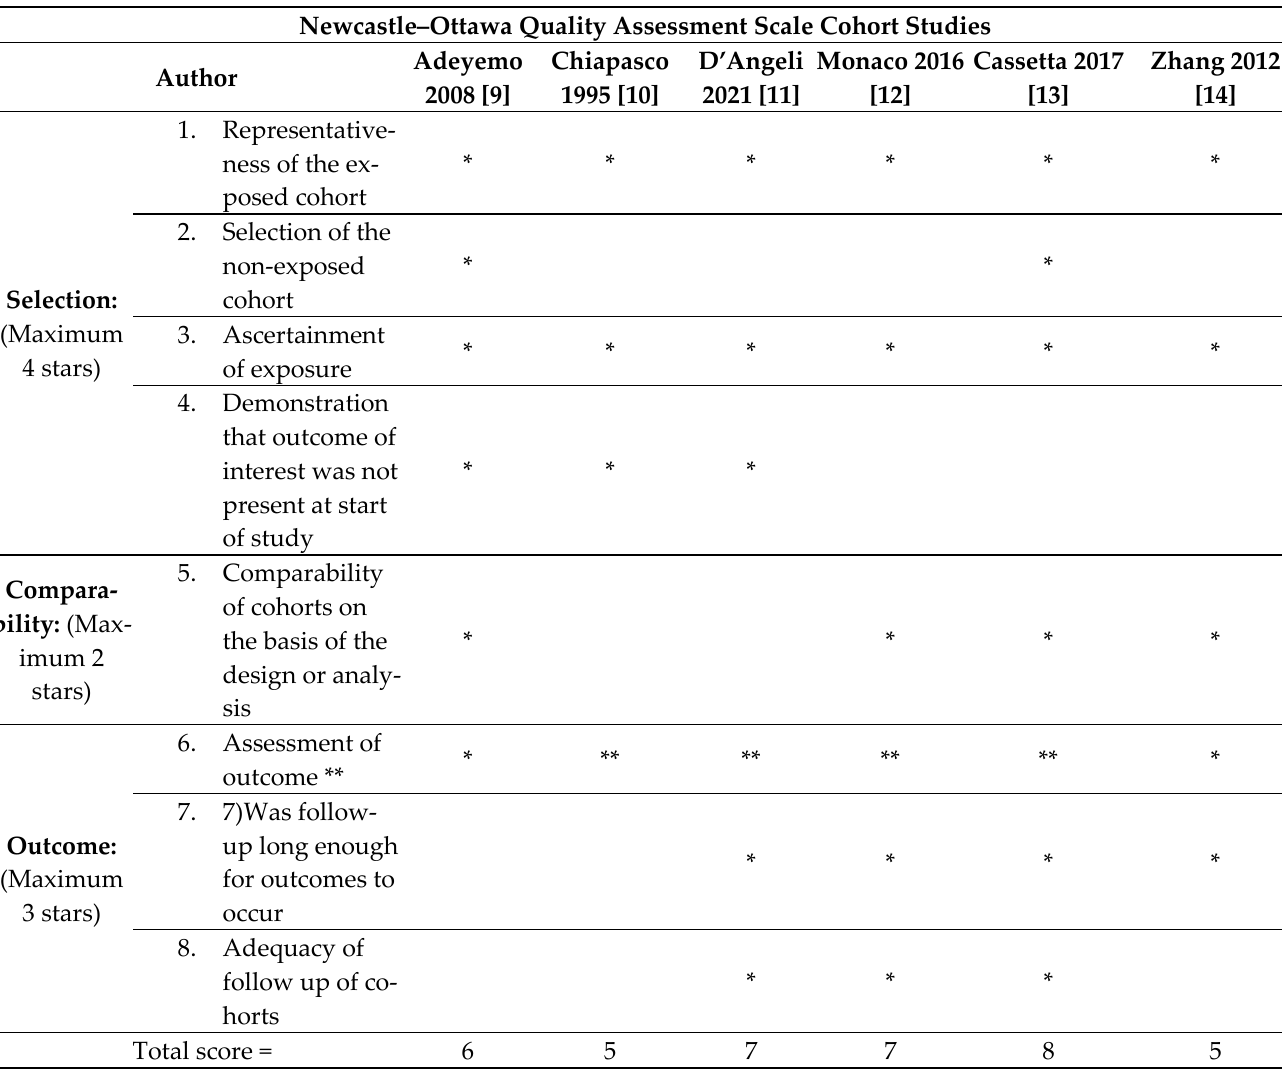
Table 4. Newcastle–Ottawa quality assessment scale for cohort studies. Table 4. Newcastle – Ottawa quality assessment scale for cohort